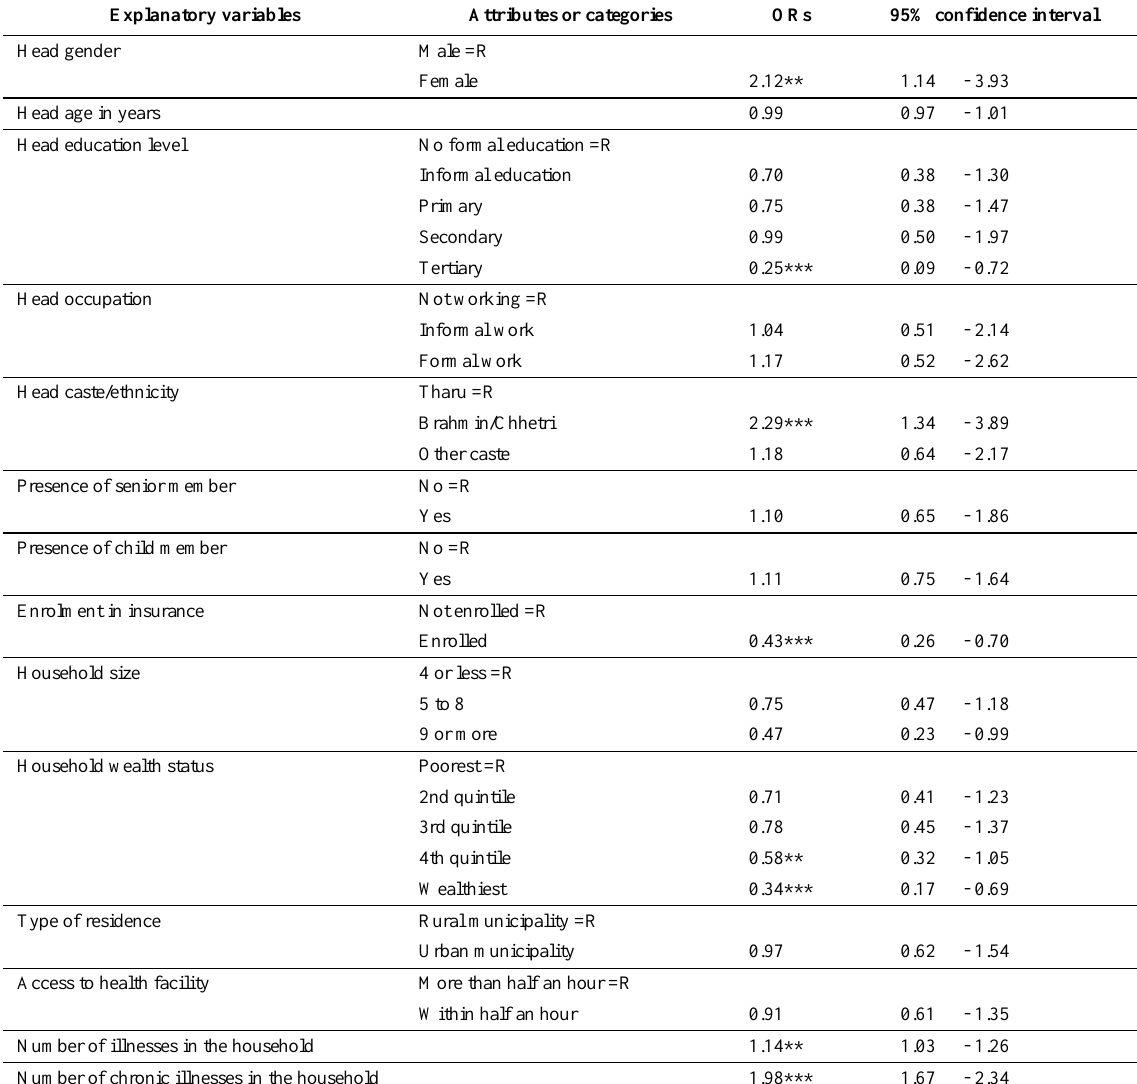
Table 4. Logistic regression analysis of determinants of CHE in the month prior to the